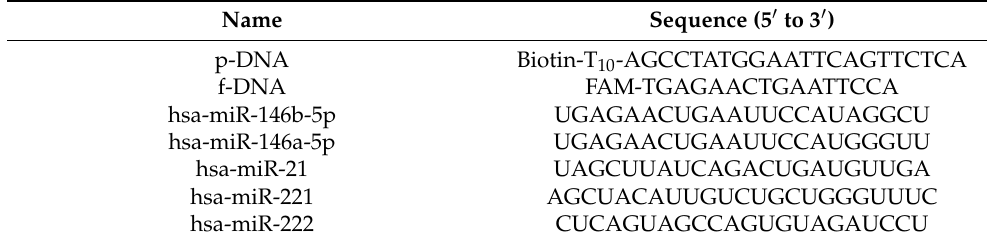
Table 1. Sequences of oligonucleotides used in the experiments.